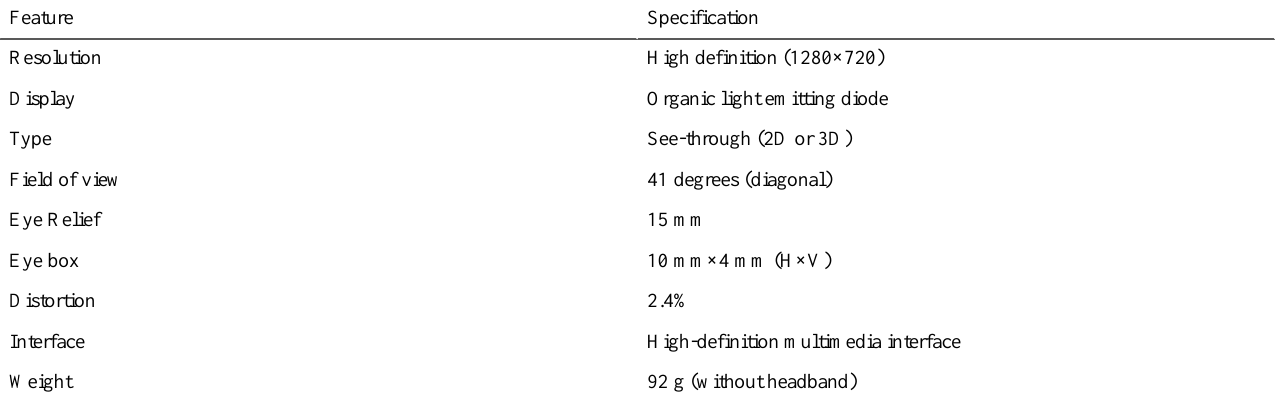
Table 2. Specification of the head-mounted